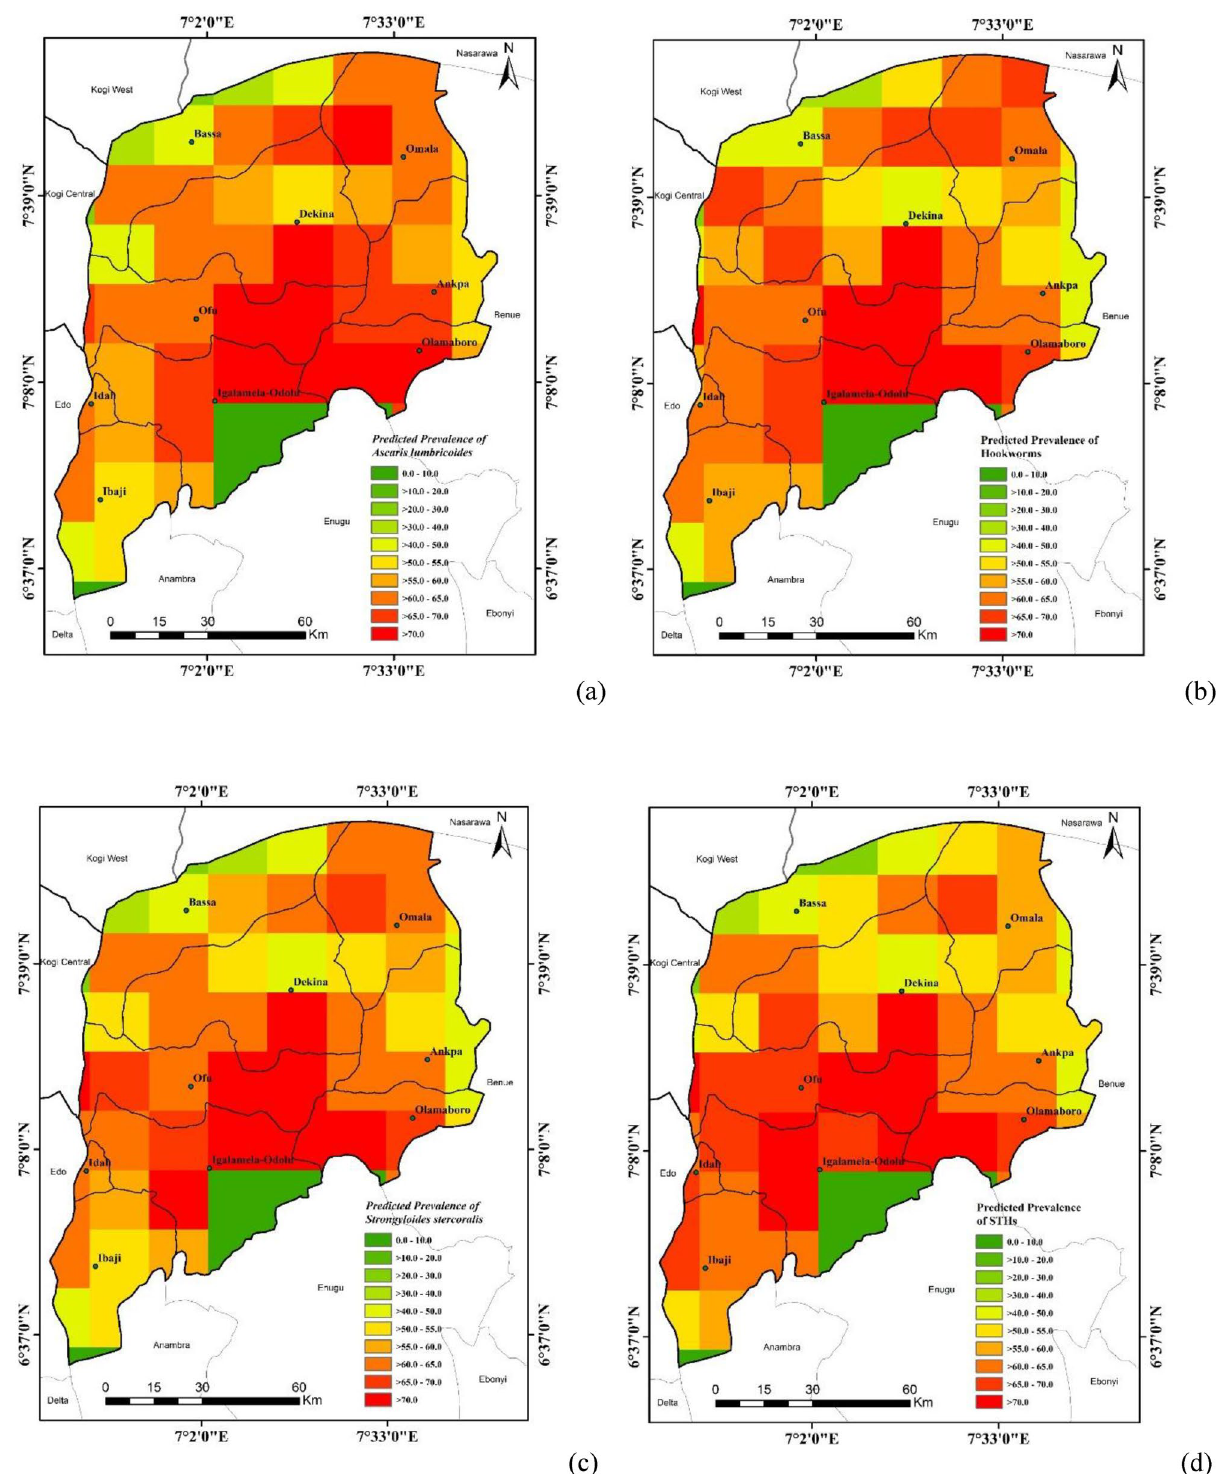
Figure 3. High Resolution Risk Maps of STHs in Kogi East, North Central Nigeria a A. lumbricoides b Hookworms c S. stercoralis d STHs Combined. Maps were visualized on ArcMap